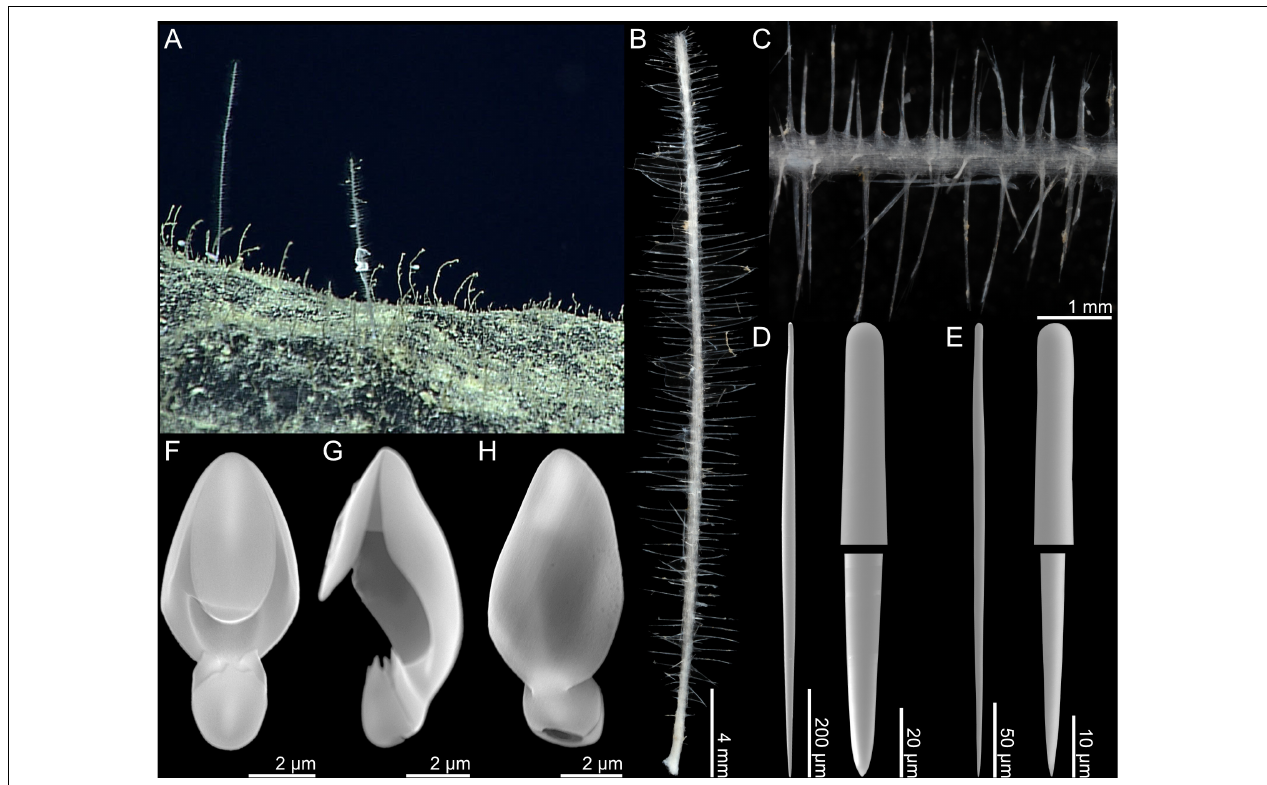
FIGURE 10 | Lycopodina subtile n. sp. (A) In situ image from ROV video, (B) holotype USNM 1424167, (C) stem detail, (D) large style, (E) small style, (F–H) palmate anisochela front, side and back